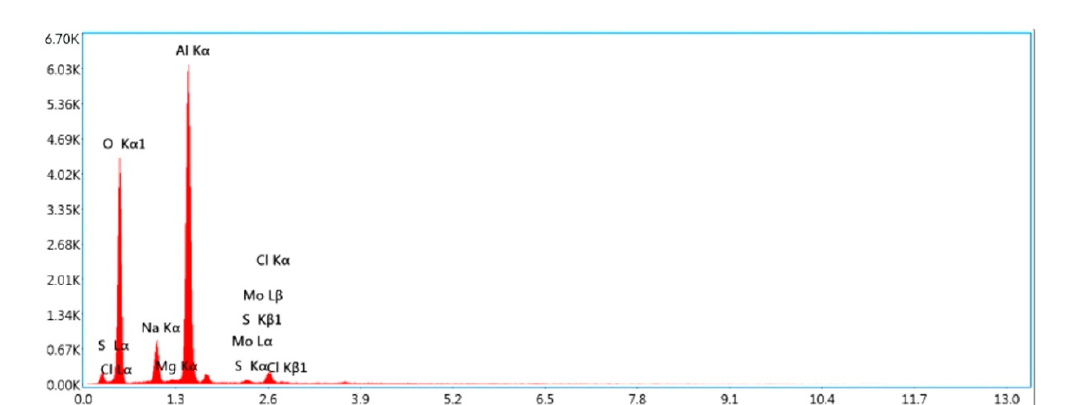
Figure3 EDX image of machined surface initial conditions.